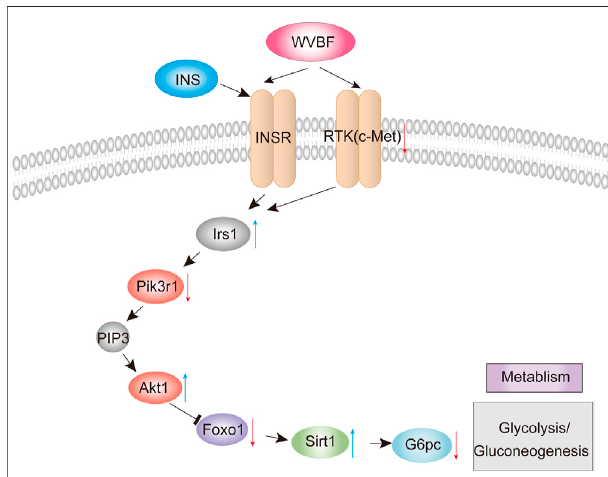
FIGURE 4 | WVBF-mediated pathways in diabetic liver